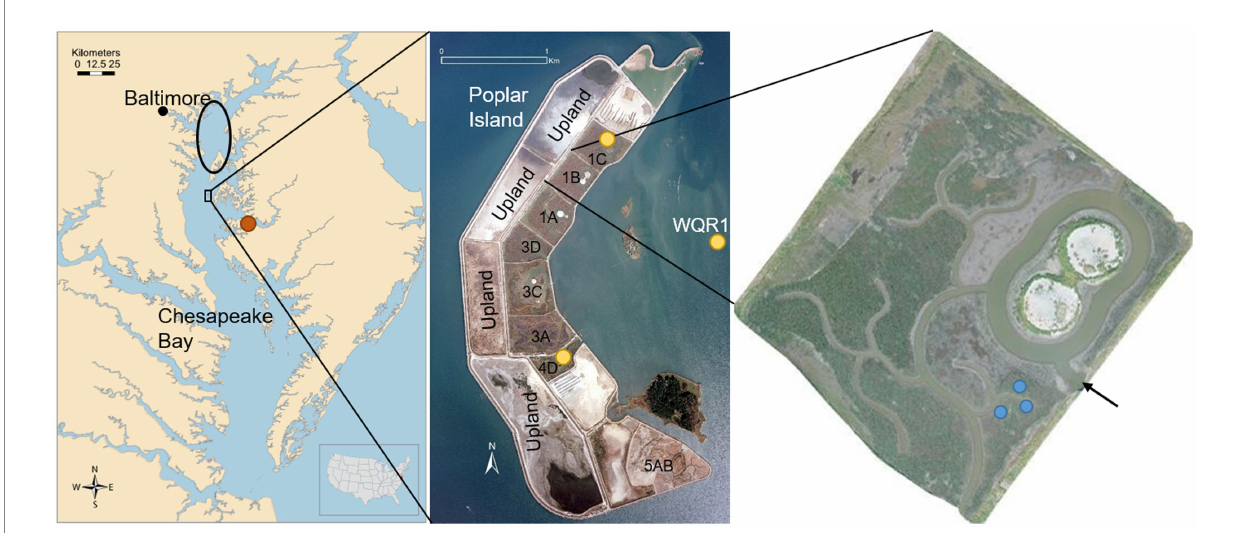
FIGURE 1 Location of study site in Chesapeake Bay, United States (left), showing the source of dredged material (black oval), the natural reference marsh at Horn Point Laboratory (HPL, orange dot), and Poplar Island (black rectangle). Middle inset shows island configuration, with yellow dots indicating dissolved Si monitoring sites (Cells 4D, 1C and Poplar Harbor, WQR1). Right inset is Cell 1B, the site of tidal flux and soil amendment studies, showing the tidal inlet (black arrow) and soil amendment plots (blue dots). Map credit (left),Tracey Saxby, Kate Boicourt, Integration and Application Network